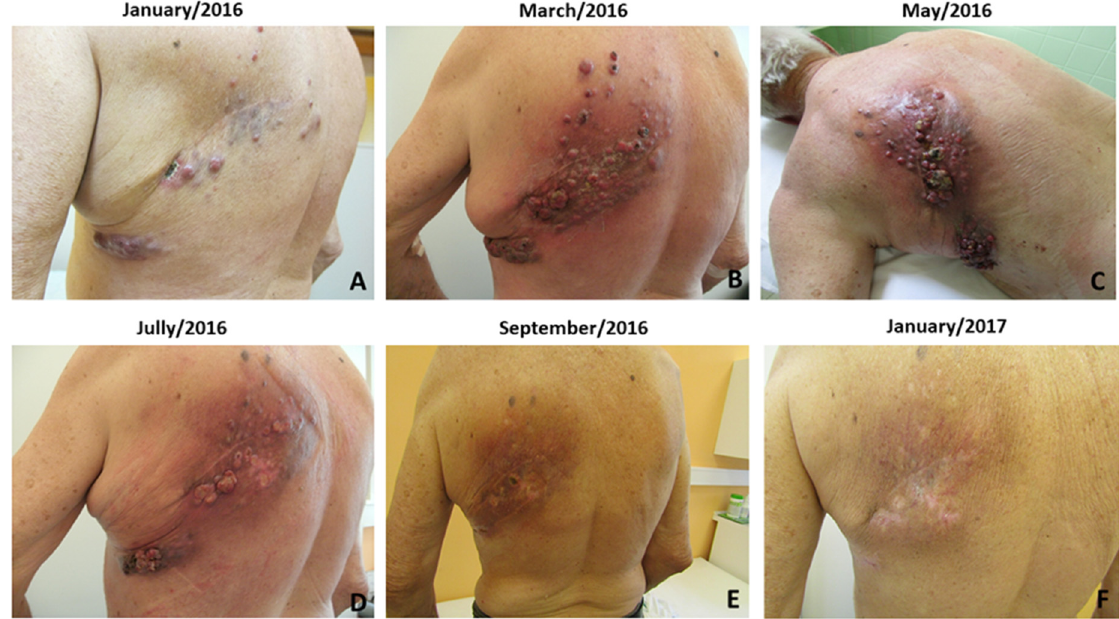
Figure 3. Clinical features at the beginning of ipilimumab therapy ( A ), after ipilimumab therapy cessation ( B ) and during perioperative preparation before cryotherapy ( C ). In the second row, we show clinical features during regression, before the 2nd cryotherapy ( D ), where partial regression was present, and the patient reported significant relief. Next, clinical pictures show practically healed skin lesions two months after cryotherapy ( E ), and already fully healed lesions on the back, where only scarring changes are visible, half a year after cryotherapy ( F ).